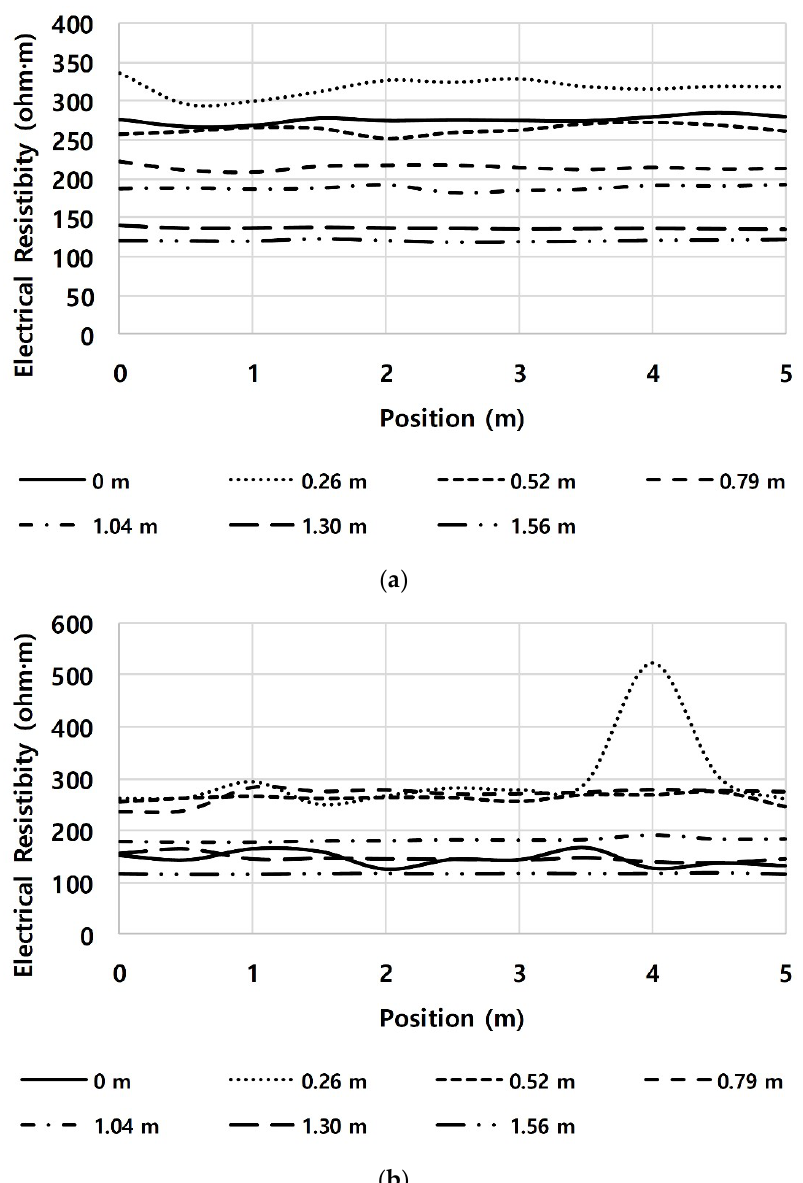
Figure 16. ER according to position at each depth. ( a ) Absence of anomaly zone (Section No. 1). ( b ) Existence of anomaly zone (Section No. 3).